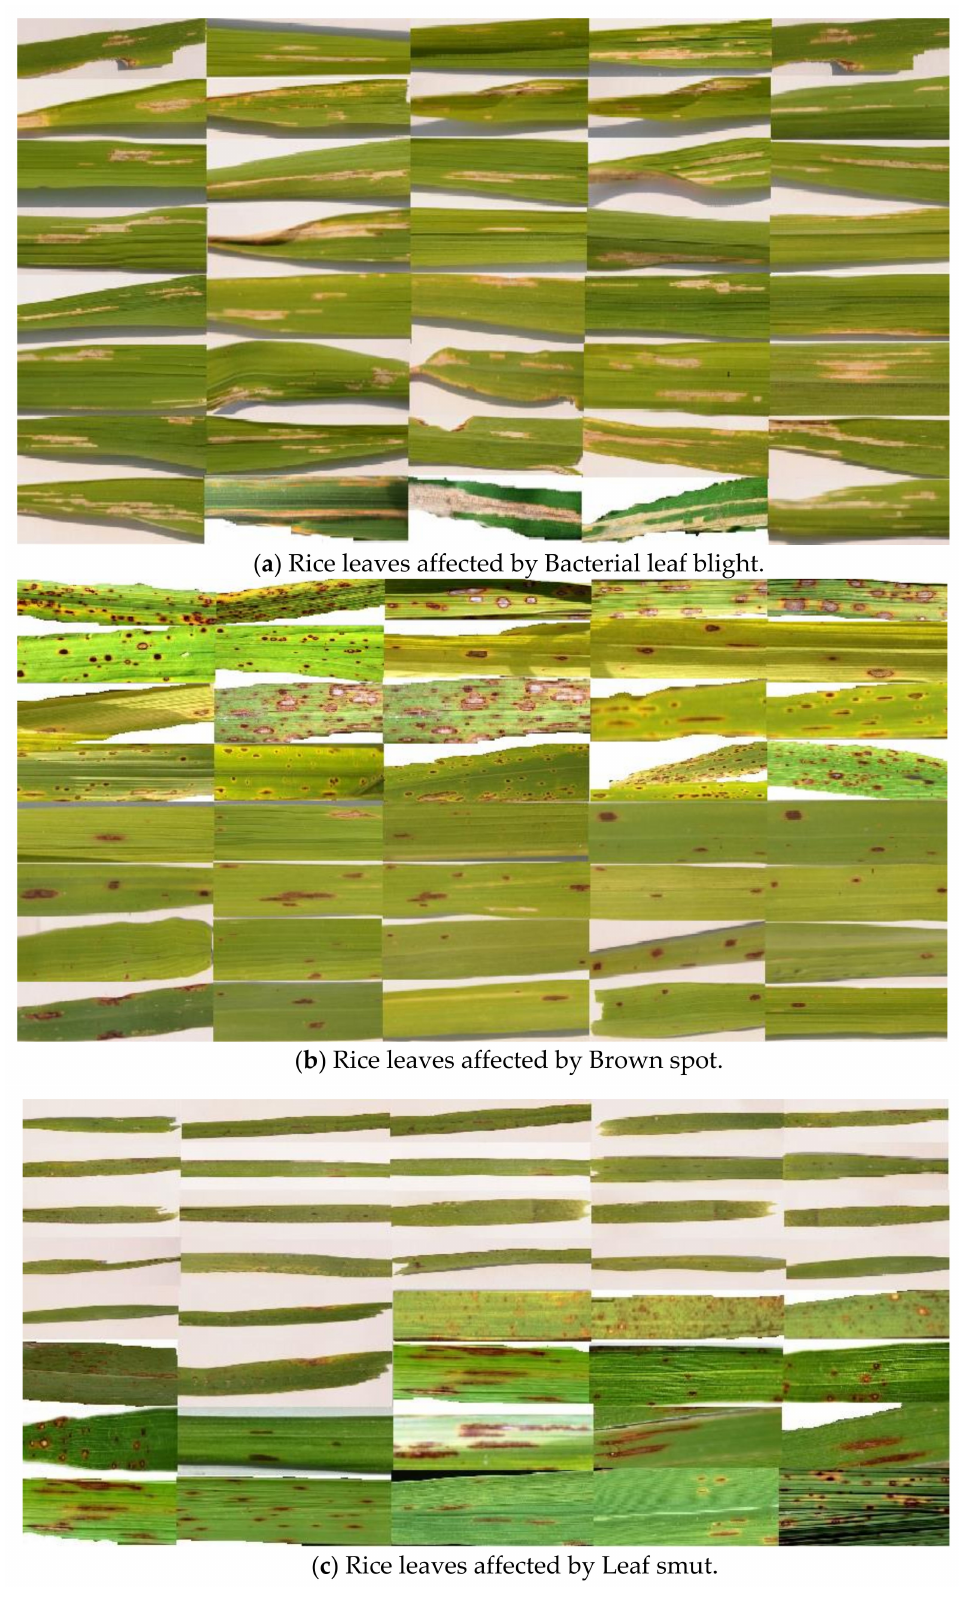
Figure 3. ( a ) Rice leaves affected by bacterial leaf blight; ( b ) Brown spot; ( c ) Leaf smut. The pictorial data above and other numerical data are integrated into structured and unstructured